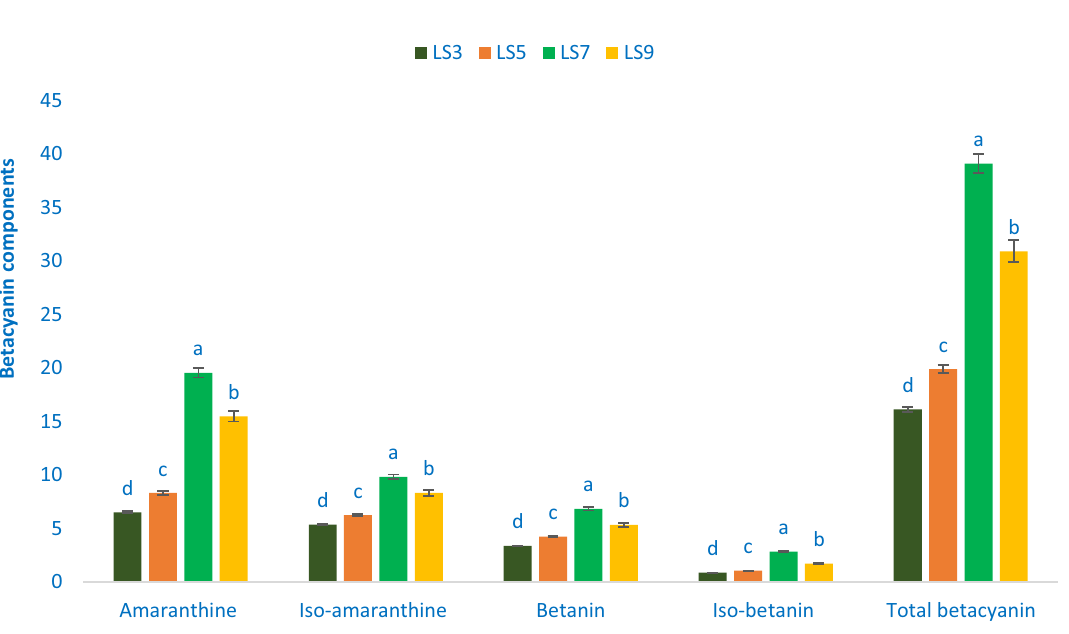
Figure 2. Betacyanin profiles in four selected A. gangeticus leafy vegetables, Amaranthine (mg 100 g −1 ), different letters in the bar are differed significantly by Duncan Multiple Range Test ((P < 0.01), (n =